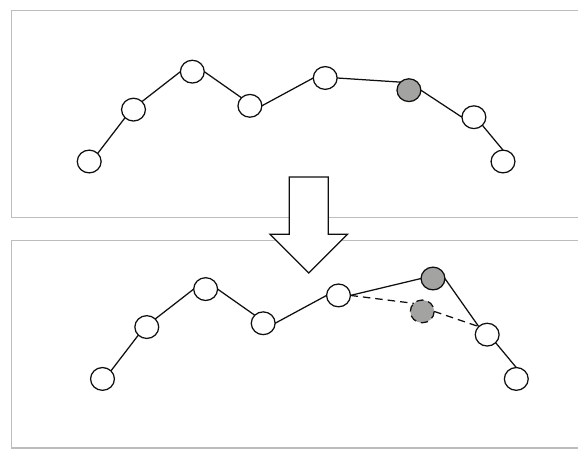
Figure 13: Apply perturb mutation operator to generate offspring.